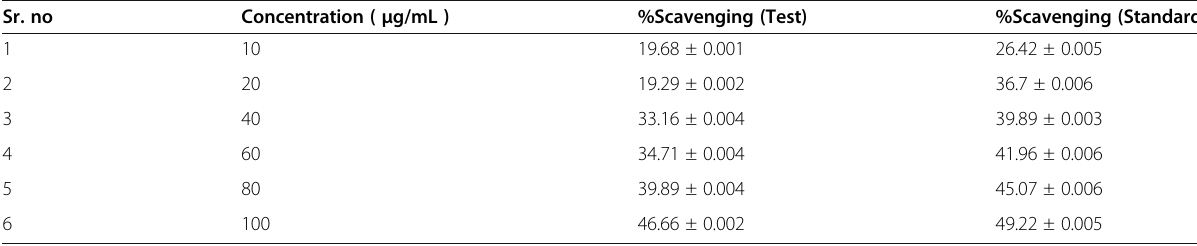
Table 4 DPPH Scavenging Activity of MELCL